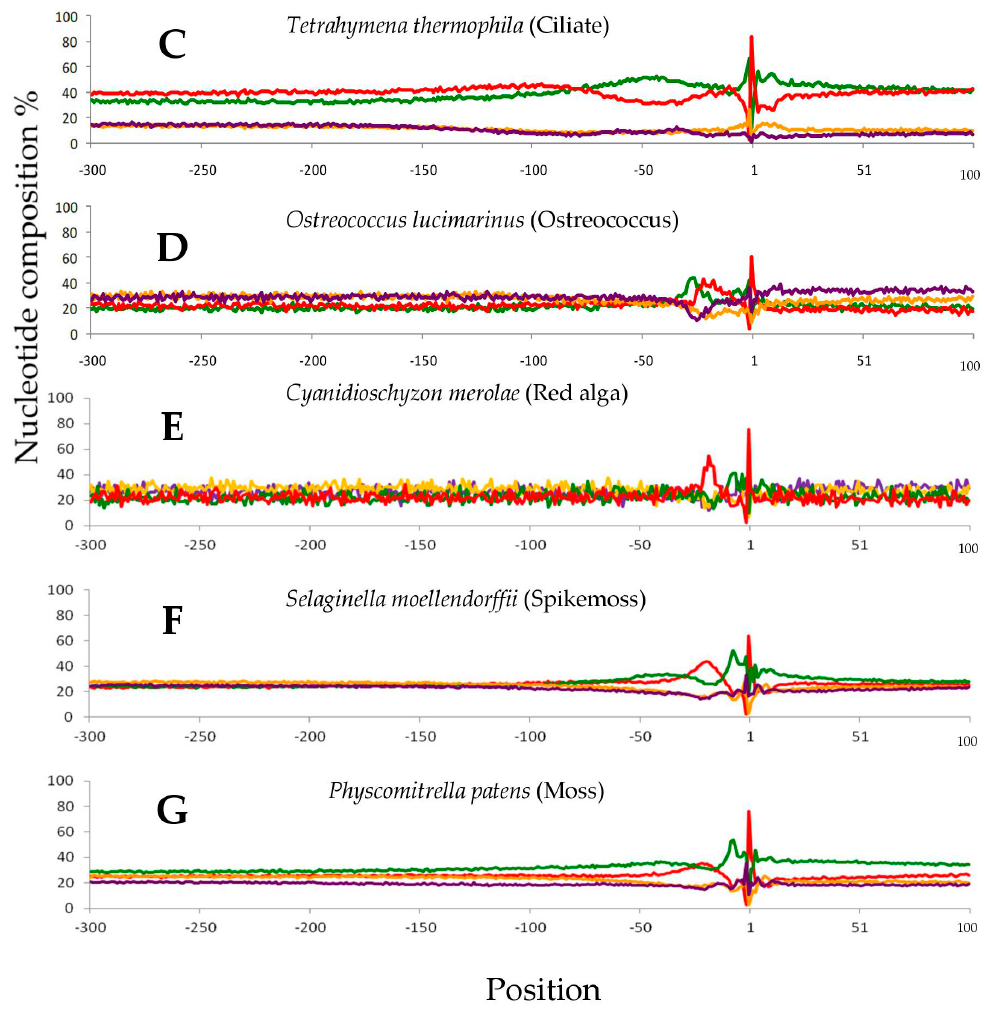
Figure 1. The single nucleotide profiles around poly(A) sites for the seven species. The − 1 position is poly(A) site, “ − ” is designated as the upstream sequences (300 nt), and “+” represents the downstream sequences (100 nt). ( A ) diatom Thalassiosira pseudonana , ( B ) diatom Phaeodactylum tricornutum , ( C ) ciliate Tetrahymena thermophila , ( D ) green alga Ostreococcus lucimarinus , ( E ) red alga Cyanidioschyzon merolae , ( F ) spikemoss Selaginella moellendorffii , ( G ) moss Physcomitrella patens .